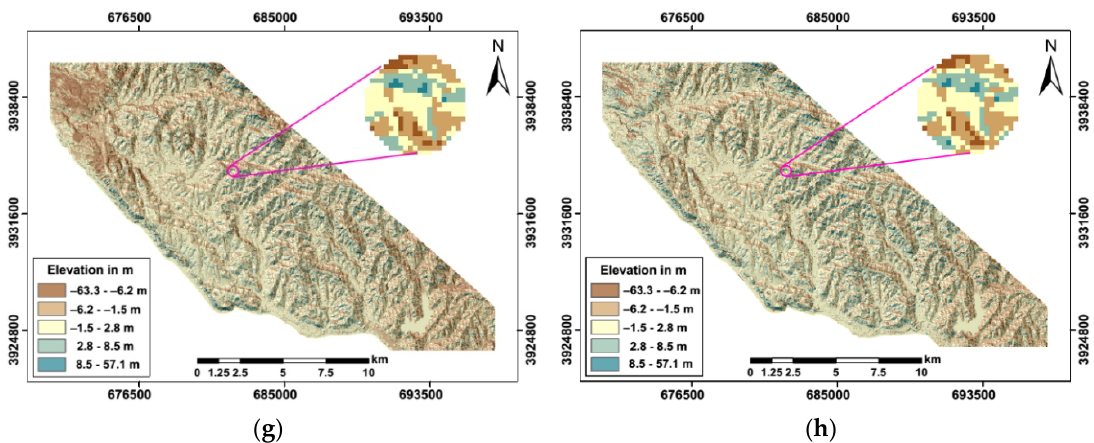
Figure 5. Elevation surface differences between: ( a ) LiDAR DTM and PALSAR DEM 28.5 m, ( b ) LiDAR DSM and PALSAR DEM 28.5 m, ( c ) LiDAR DTM and PALSAR DEM 12.5 m, ( d ) LiDAR DSM and PALSAR DEM 12.5 m, ( e ) LiDAR DTM and SRTM DEM 28.5 m, ( f ) LiDAR DSM and SRTM DEM 28.5 m, ( g ) LiDAR DTM and ALOS DSM 28.5 m, and ( h ) LiDAR DSM and ALOS DSM 28.5 m.